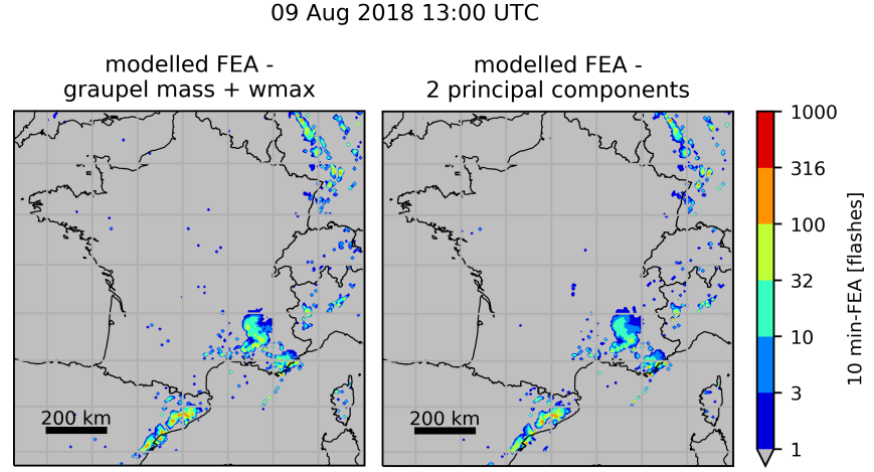
Figure 13. FEA modelled using (a) graupel mass and wmax simultaneously and (b) the first two principal components of a dataset composed of all the proxies for 9 August 2018 at 13:00UTC.